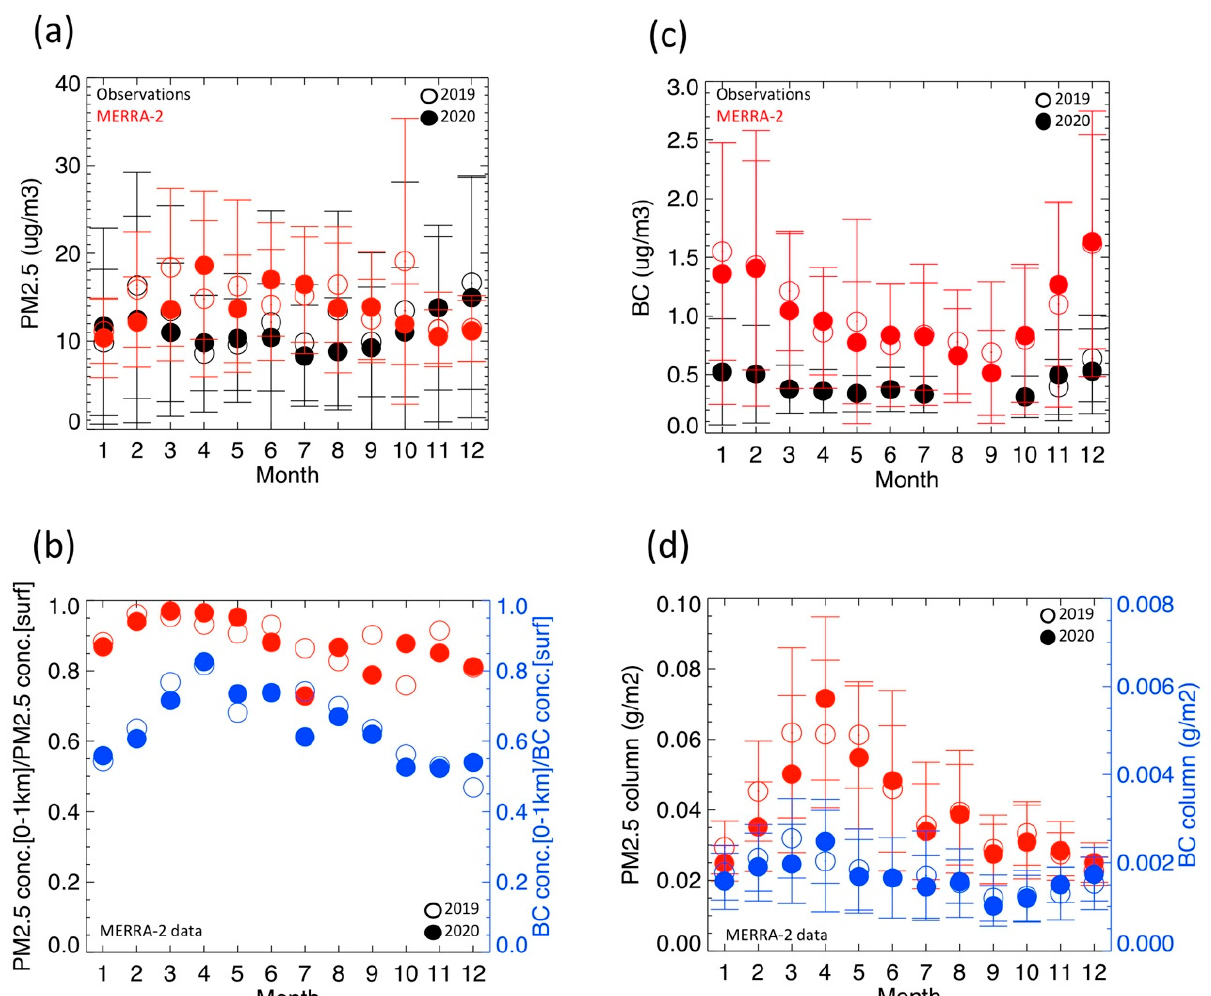
Figure 4. ( a ) Monthly surface PM2.5 mass concentrations observed at Chiba University (black) and estimated by MERRA-2 (red); ( b ) MERRA-2 monthly ratios of PM2.5 (red) and BC (blue) mean concentrations of the partial column (<1 km) to surface concentrations; ( c ) monthly average surface BC mass concentrations observed by COSMOS (black) and estimated by MERRA-2 (red); ( d ) monthly PM2.5 and BC total columns estimated by MERRA-2. Filled and empty circles show data for 2020 and 2019, respectively.